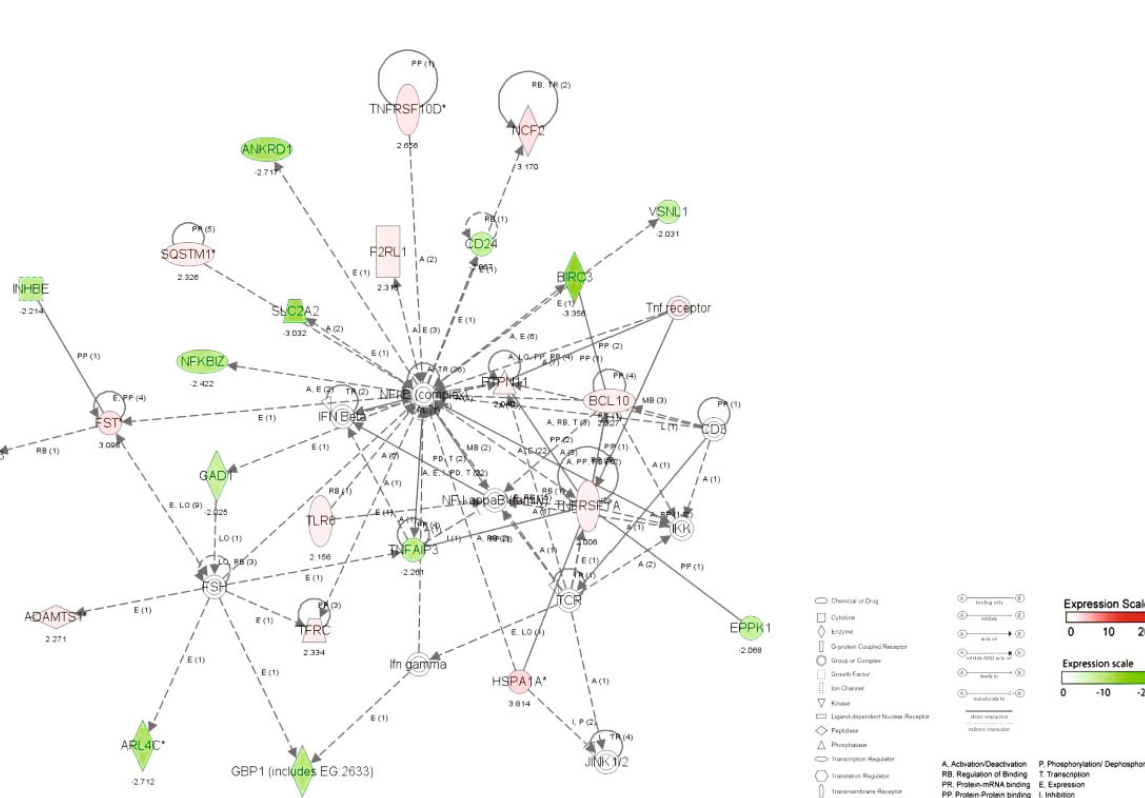
Figure 3: Top 10 molecular functions changed by DTS treatment.